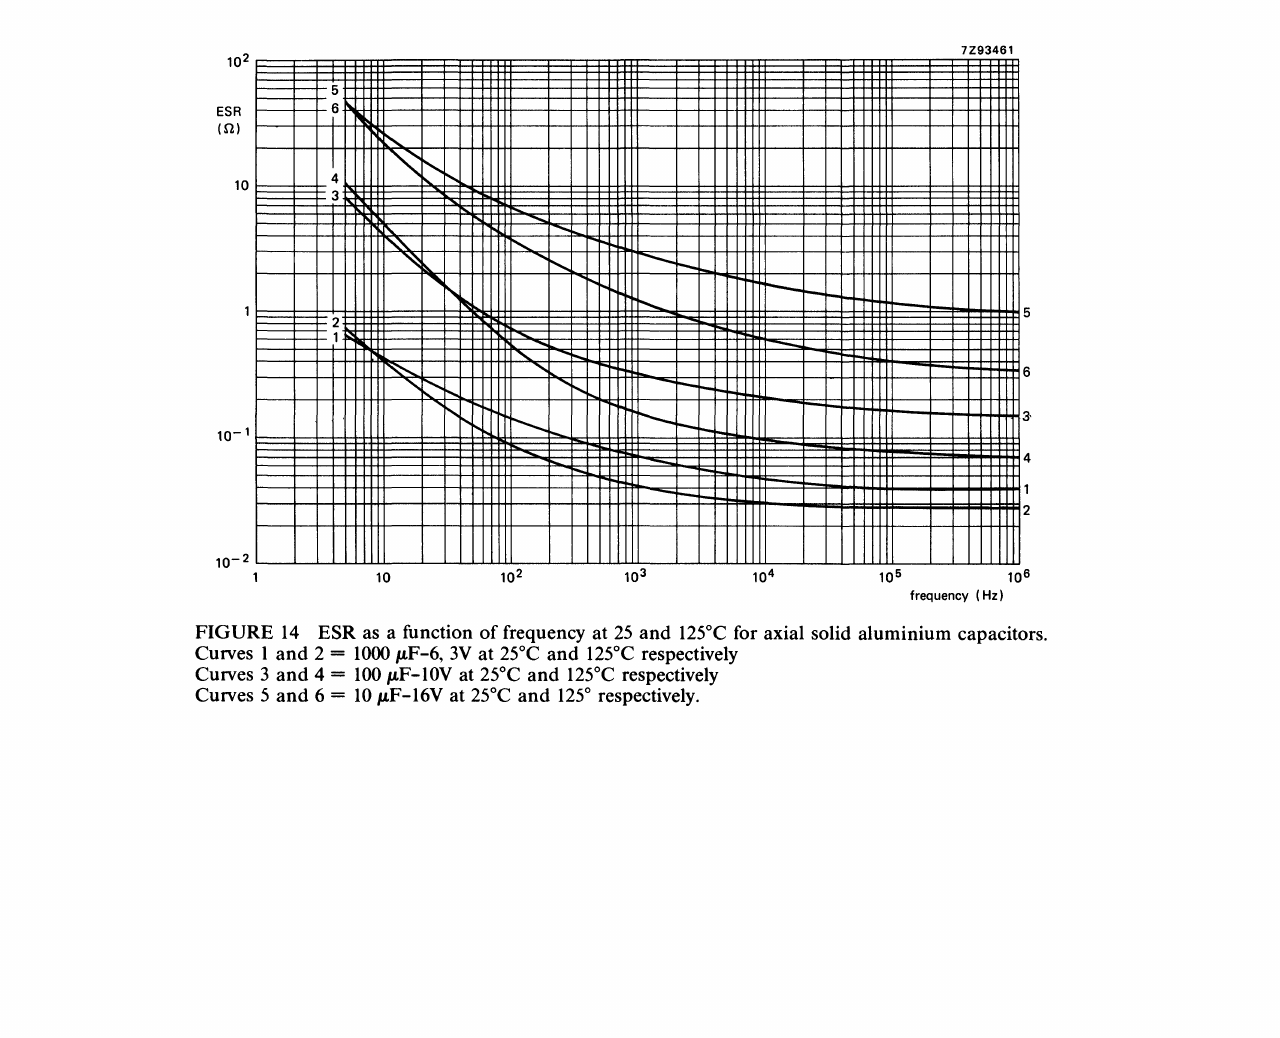
FIGURE 13 Ripple-current multiplier as a function of frequency and temperature for solid aluminium capacitors.